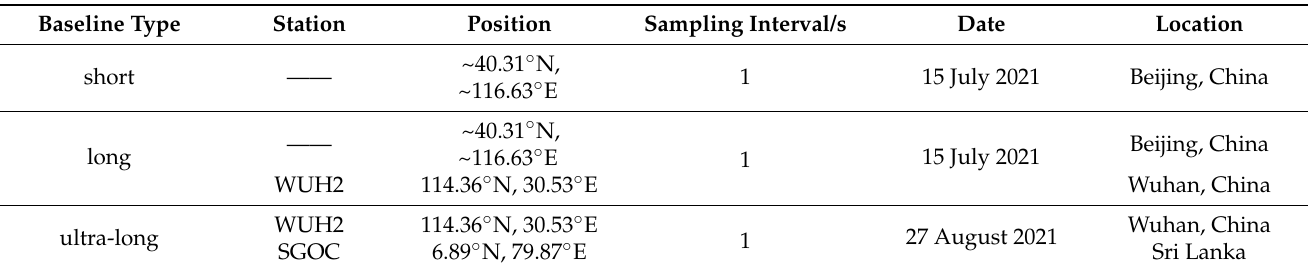
Table 6. Information under different baseline